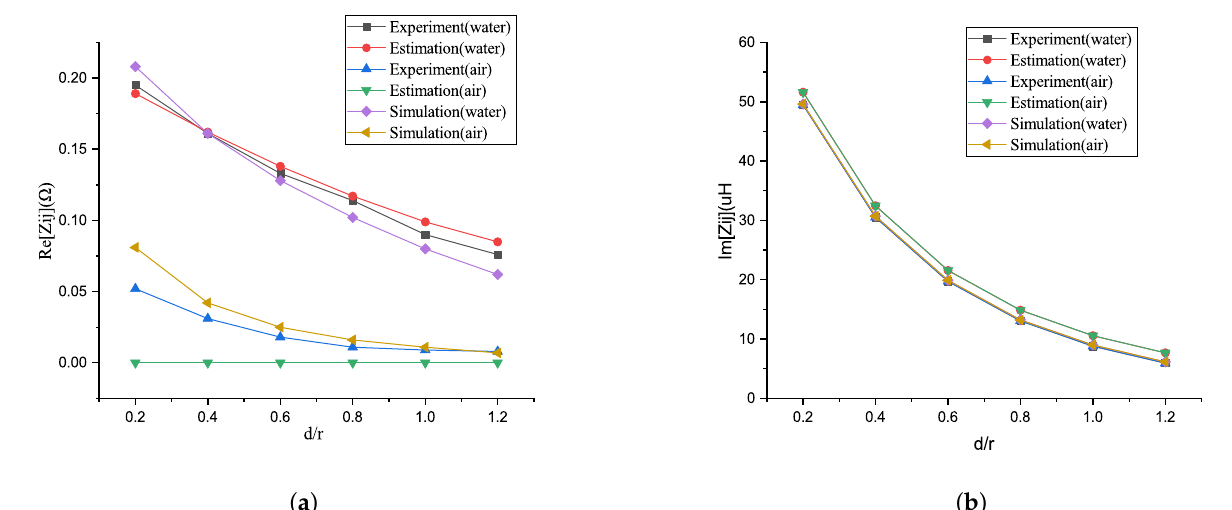
Figure 8. ( a ) The real part of mutual impedance of two coils with respect to axial displacement when f = 100 kHz, σ =0 S/m, 4 S/m. ( b ) The imaginary part of mutual impedance of two coils with respect to axial displacement when f = 100 kHz, σ =0 S/m, 4 S/m.